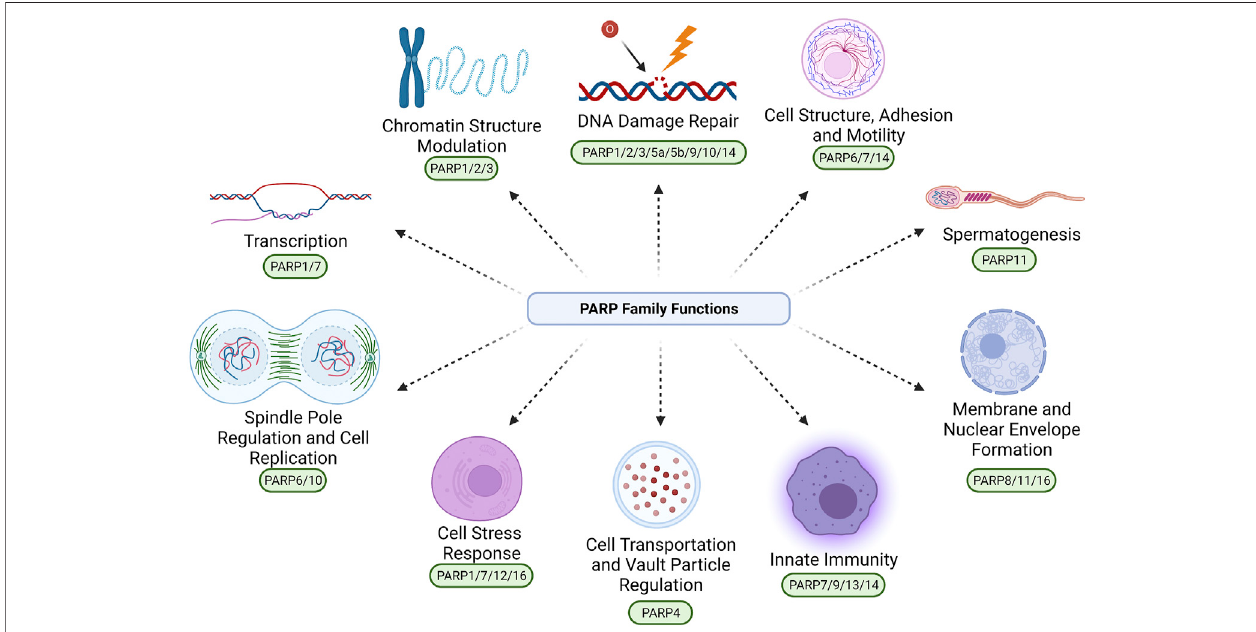
FIGURE 1 | The con fi rmed and proposed diverse roles of the PARP protein family. These roles include: DNA Damage Repair (PARP1/2/3/5a/5b/9/10/14), Cell Structure, Adhesion and Motility (PARP6/7/14), Spermatogenesis (PARP11), Membrane and Nuclear Envelope Formation (PARP8/11/16), Innate Immunity (PARP7/9/ 13/14), Cell Transportation and Vault Particle Regulation (PARP4), Cell Stress Response (PARP1/7/12/16), Spindle Pole Regulation and Cell Replication (PARP6/10), Transcription (PARP1/7), and Chromatin Structure Modulation (PARP1/2/3). Due to the large diversity of PARP activity, it is likely that PARPs are also involved in biological processes beyond those exempli fi ed in this fi gure, that are yet to be fully elucidated. Created with BioRender.com.